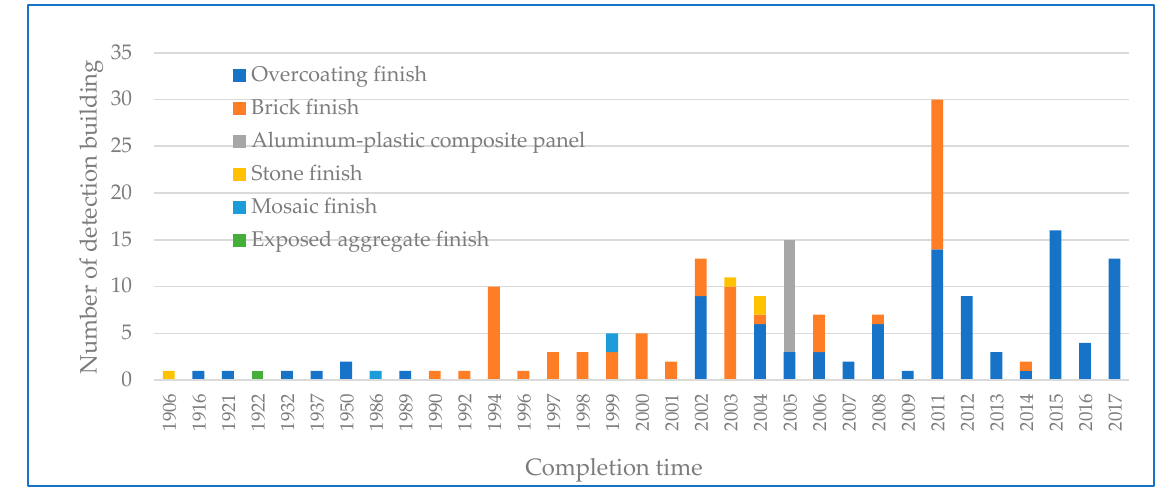
Figure 5. Type of façade finish at different completion times.